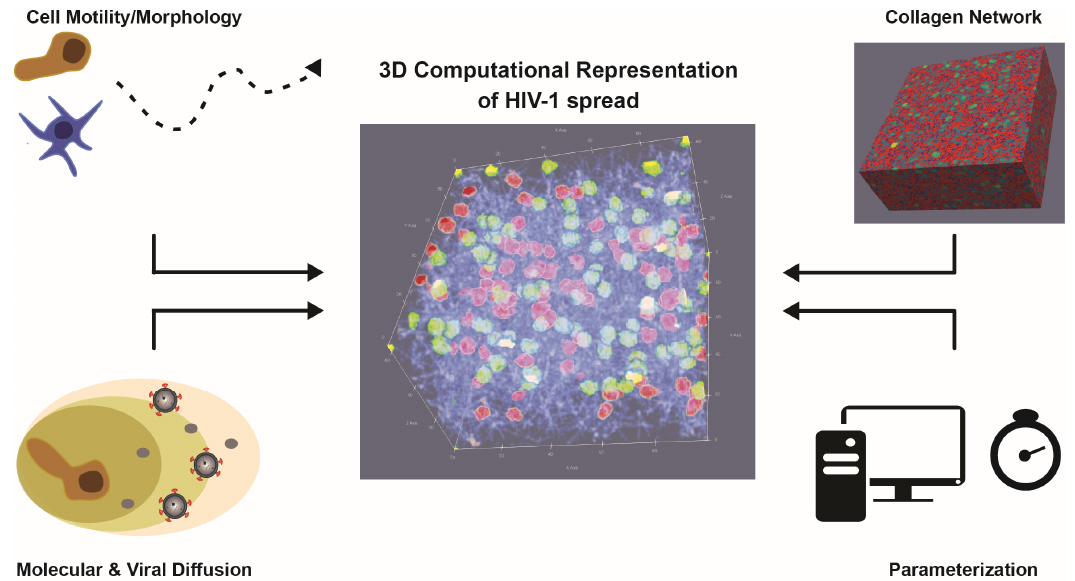
Figure 3. 3D computational representation of HIV-1 spread: Appropriate representations to infer the processes that govern the dynamics of infection require a detailed description and quantification of individual cell motility and morphology, the underlying tissue structure, and the diffusion dynamics of soluble components (chemokines, virions, etc.) within these environments. Data-driven parameterization and subsequent simulation of these 3D model systems requires computationally efficient methods. The sketch shows a computational representation of 100 HIV-1-infected (green) and 100 uninfected (red) cells within a 3D collagen matrix (blue fibers).